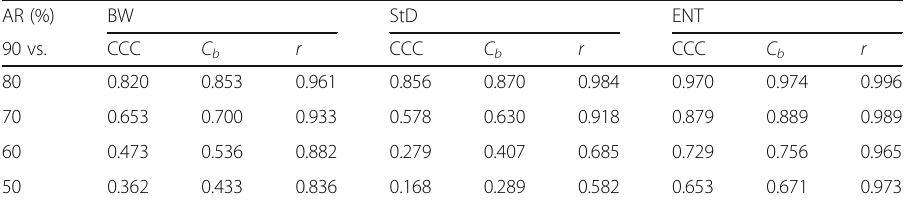
Table 2 Concordance correlation coefficients for OSEM reconstructions for patients whose unaltered activity ratio was > 90% AR (%) BW StD ENT 90 vs.